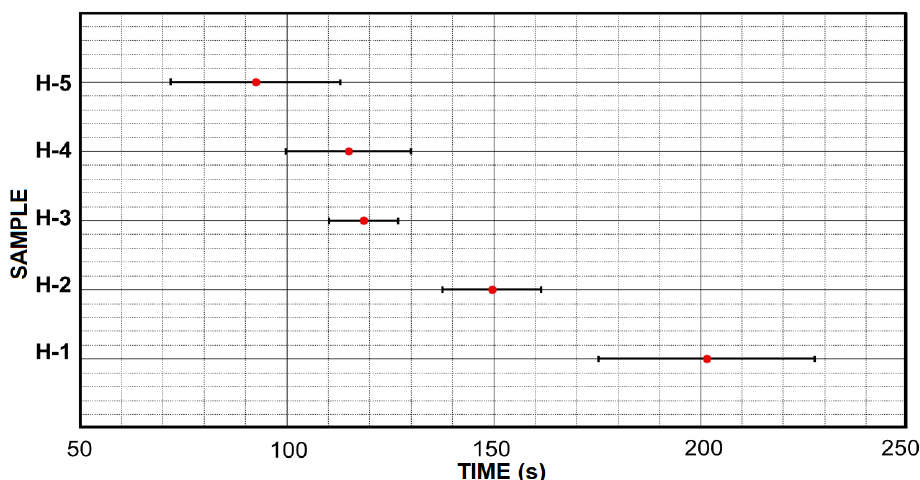
Figure 9. The initiation of gelation times of each sample is shown together with its standard deviation. The H-5, H-4 and H-3 samples show some similarity while the H-1 and H-2 samples are out of phase with their high initiation of gelation